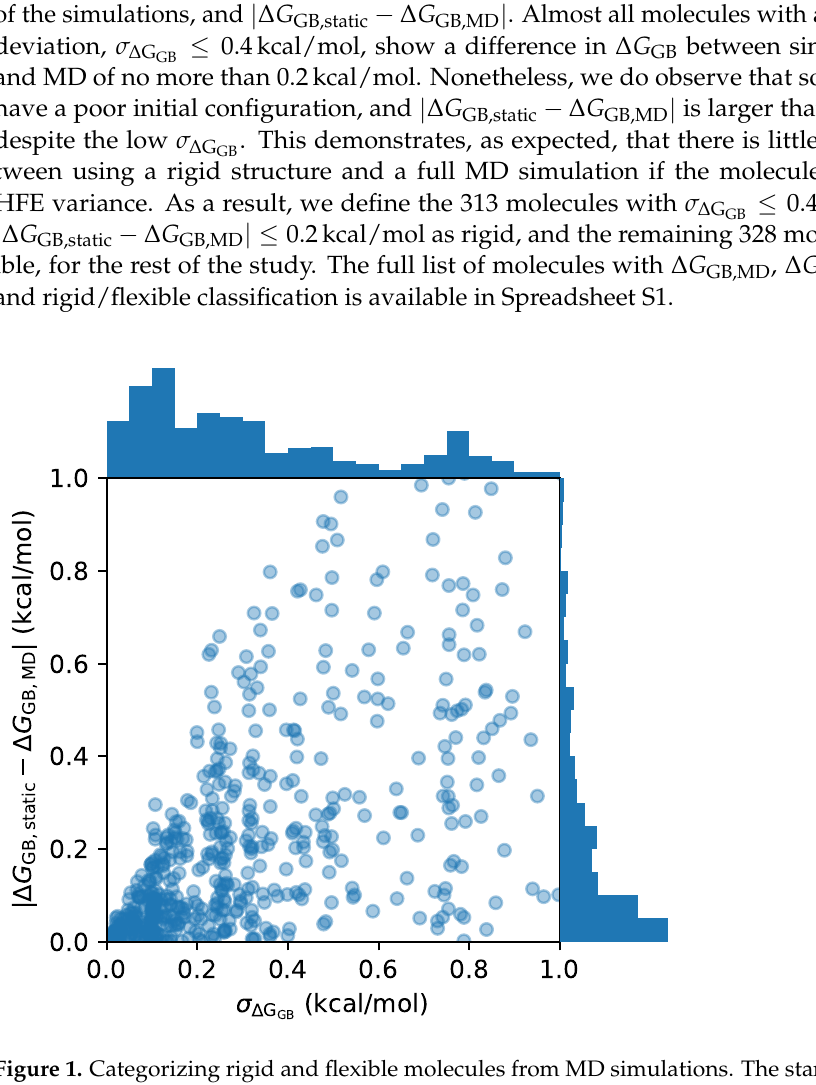
= 4.0kcal/mol and GB